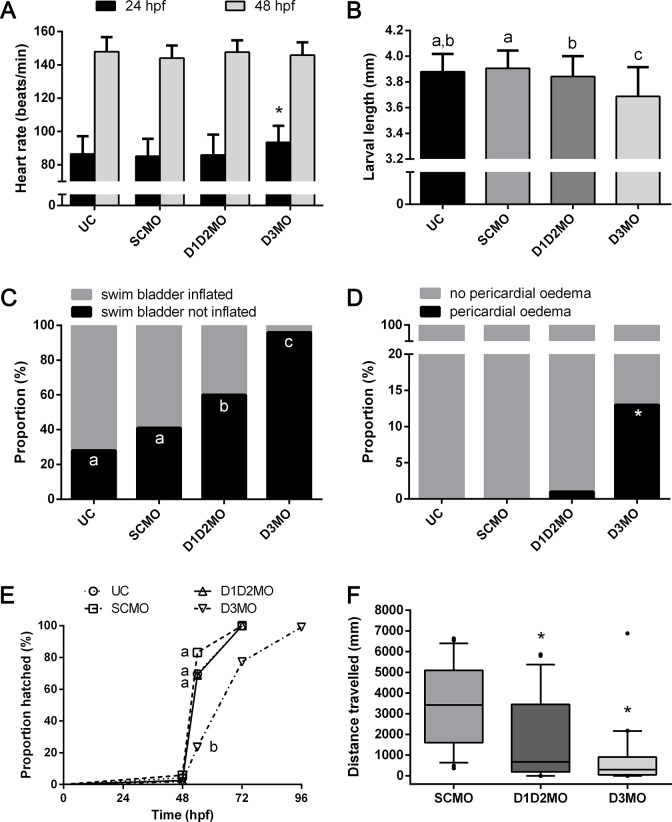
Phenotypic effects observed in D1D2MO and D3MO zebrafish larvae.(A) heart rate at 24 and 48 hpf, (B) larval length at 96 hpf, (C) swim bladder inflation success at 96 hpf, (D) frequency of pericardial oedema at 96 hpf, (E) hatching success as a function of time, and (F) larval motility at 96hpf: boxplot with median, 10 and 90 percentile of the travelled distance during 45 minutes. In (A) and (B), data are shown as average ± SD and SD was calculated over all individual embryos. Knockdowns were initially compared to SCMO, and * indicates a significant difference from SCMO. If further differences were observed, additional comparisons were made, and different letters indicate significant differences among experimental groups. In (E), letters indicate significant differences among hatching curves taking all time points into account. D1D2MO: combination of deiodinase type 1 and type 2 morpholino-injected, D3MO: deiodinase type 3 morpholino-injected, UC: uninjected control. SCMO: standard control morpholino-injected.